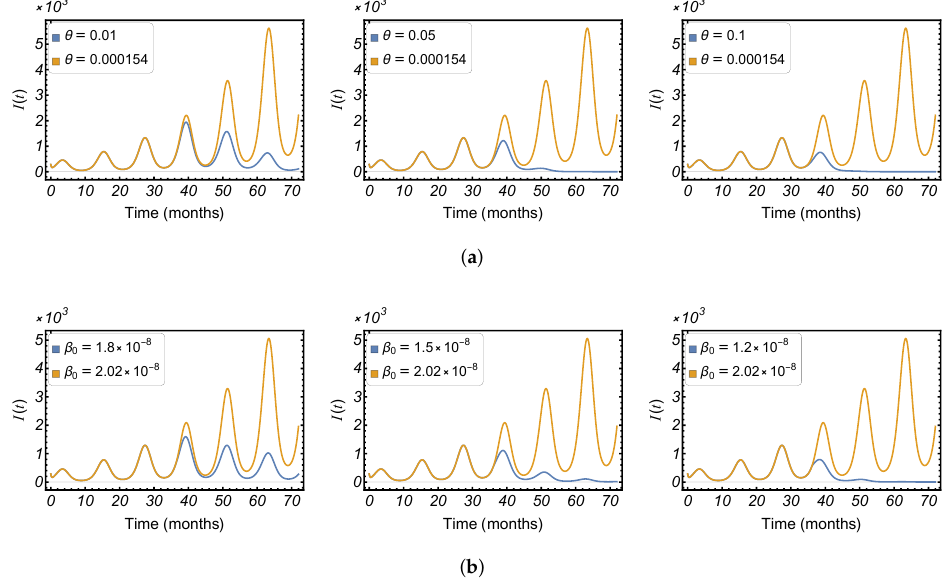
Figure 11. Effects of possible parameter modifications on the potential for reducing or eradicating the measles epidemic, in ( a ) the vaccine coverage rate θ and ( b ) the baseline contact rate β 0 , utilizing the parameter values listed in Table